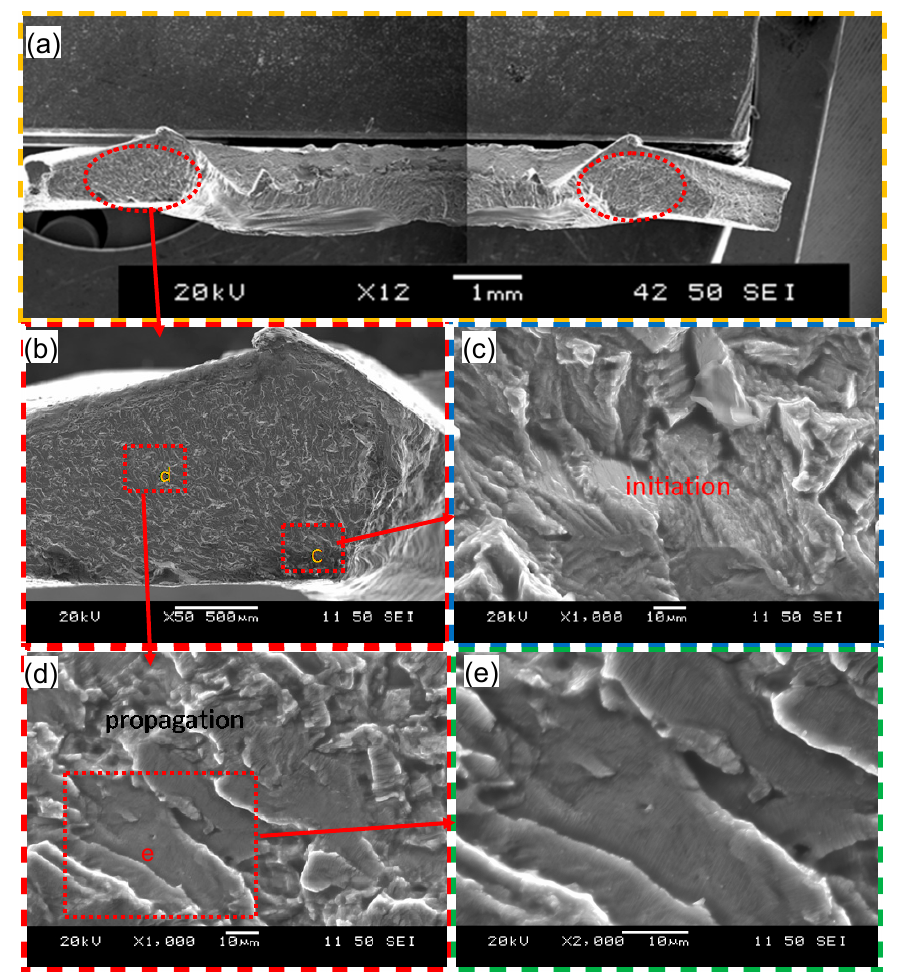
Figure 8. Typical SEM images of a fatigue failed sample made at a welding energy of 1400 J and tested at a maximum load of 0.5 kN. ( a ) Overall view of the entire fracture surface and ( b – e ) magnified view of the regions of interest indicated in ( a , b ).